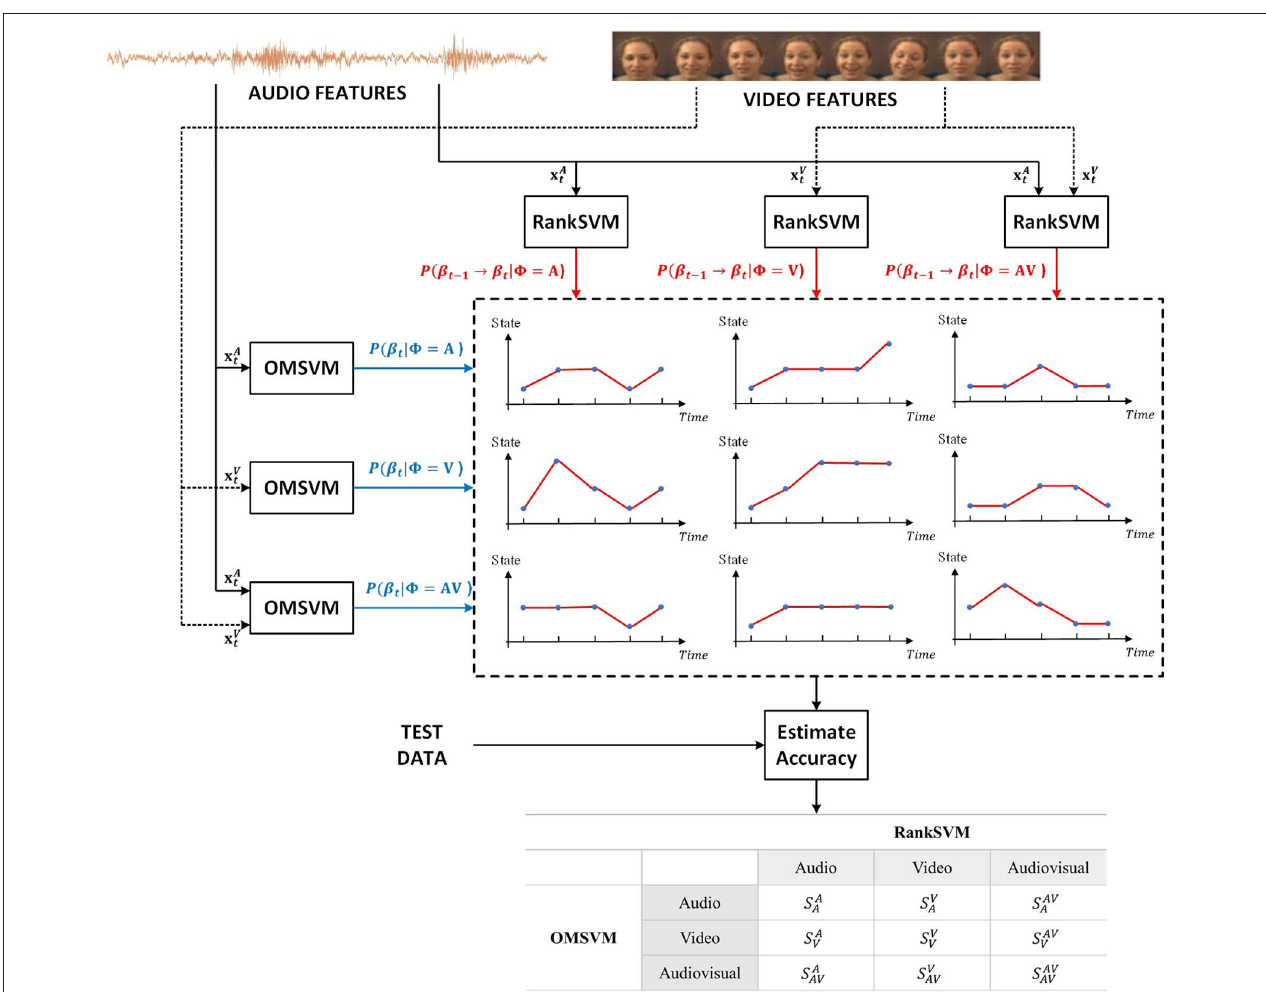
FIGURE 4 | An overview of the proposed analyses to determine relative salience of audio and video modalities toward the perception of emotion state and emotion change. The 9 possible DOMM systems corresponding to different combinations modalities used for estimating state and transition probabilities are all evaluated on the same test data. A table of these measures of prediction accuracy, as illustrated, allows for the identification of broad trends around the relative salience of each modality toward the prediction of emotion state and emotion